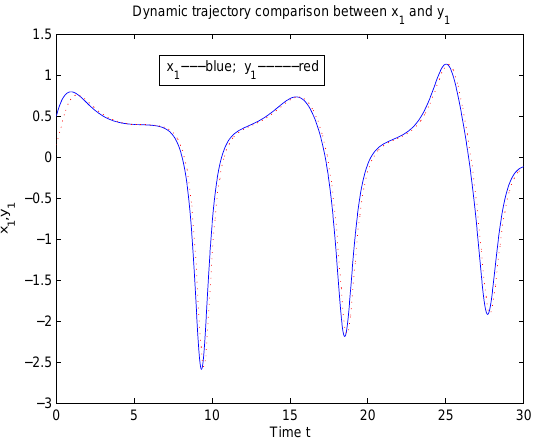
Figure 3. Three-dimensional view synchronization for fractional-order 0.95.